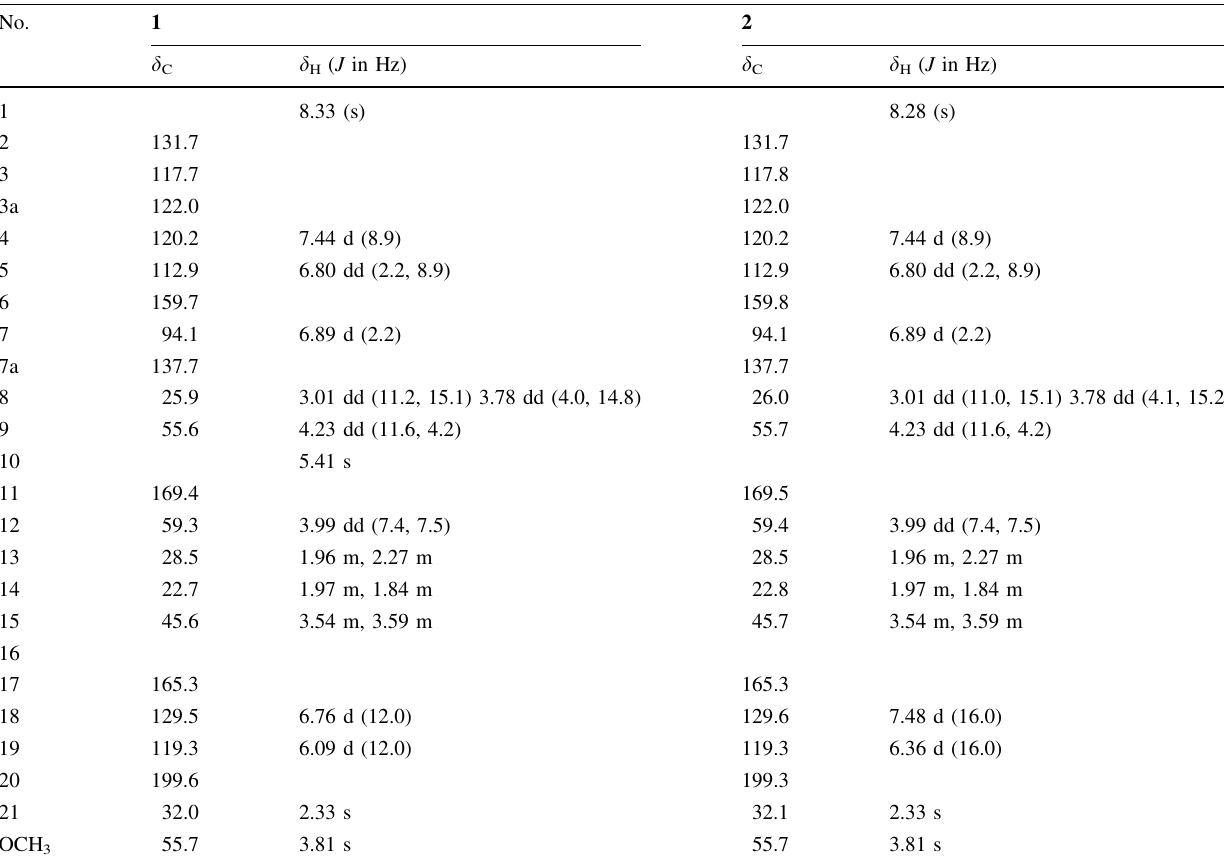
Table 1 1 H and 13 C NMR spectroscopic data (in CDCl 3 ) of 1 and 2 . ( d in ppm)